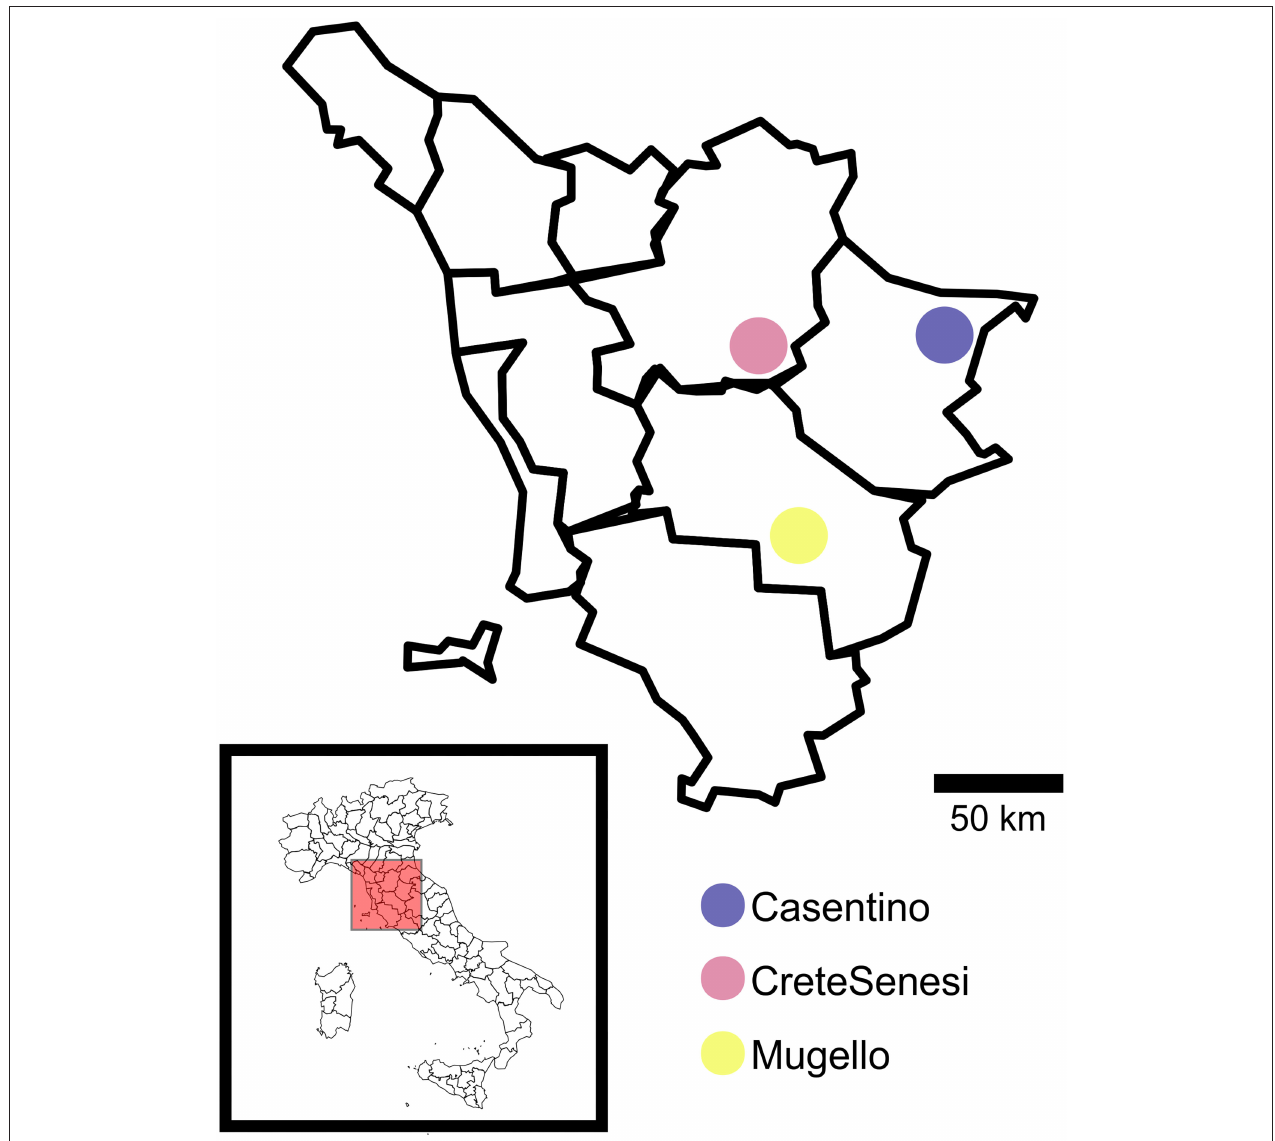
FIGURE 1 | Geographical localization of truffle samples listed in Table 1 . This figure was generated using R package “ maps